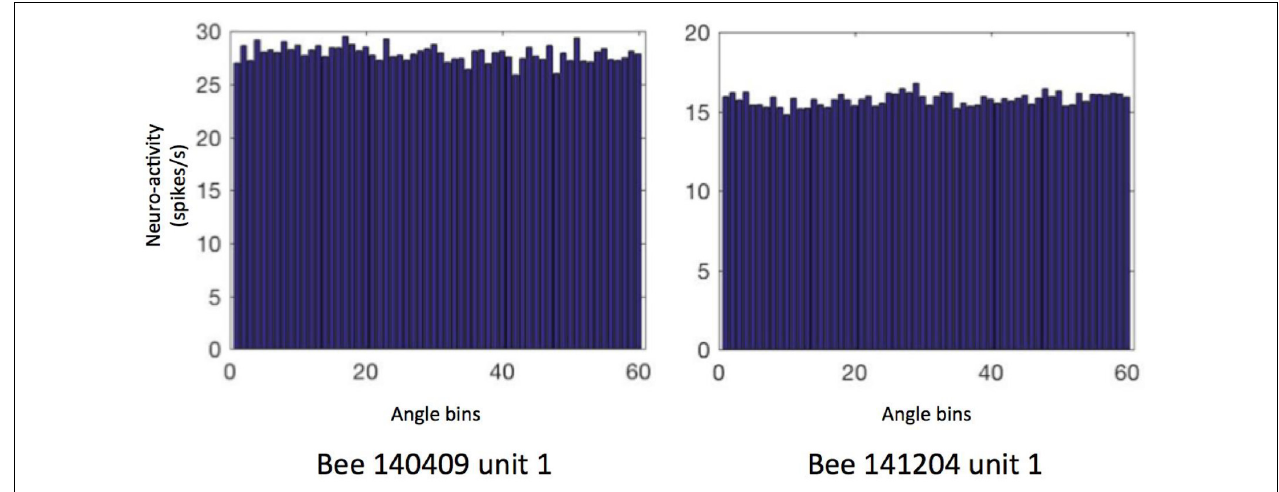
FIGURE 6 | Heading direction related neural activity in two neurons. The spiking frequency in 360 ◦ of arena is binned into 60 sectors (i.e., 6 ◦ /sector) and then averaged. Data of other units are in Supplementary Figure S2 . The directional ICs of unit 1 in bee # 140409 and unit 1 in bee # 141204 are 0.0004 and 0.001, indicating no direction-predictive (or so-called “head direction cell”) property in these